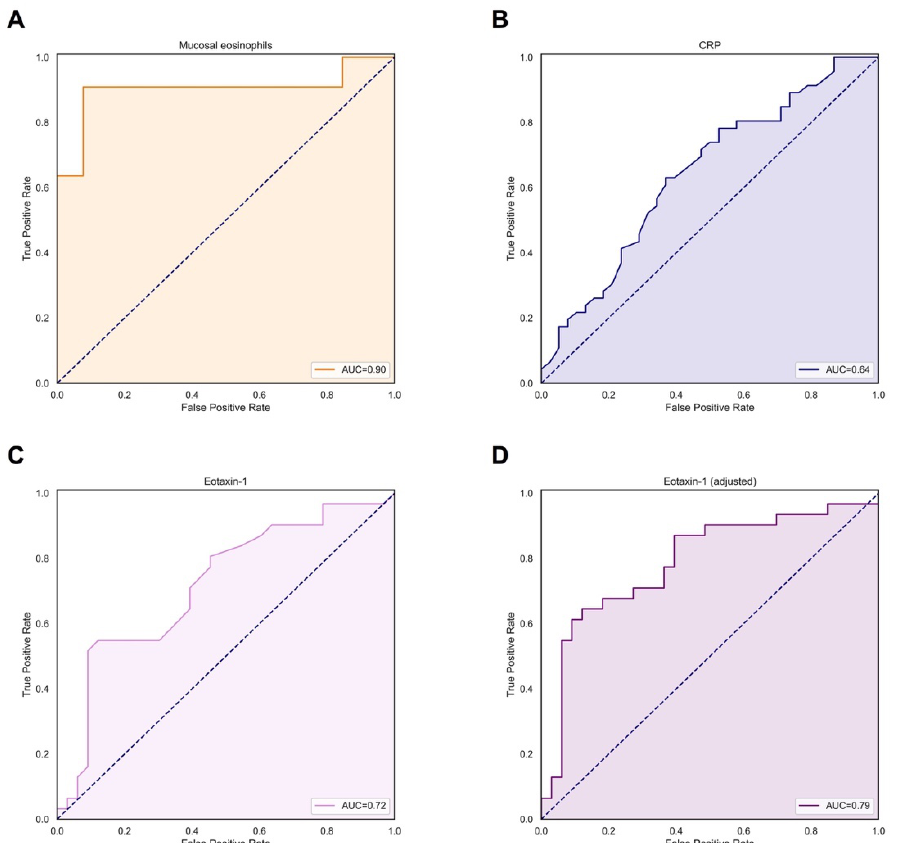
Figure 3. ( A – D ) Receiver operating characteristics (ROC) curves for mucosal eosinophil counts/hpf. ( A ), serum CRP levels (mg/L) ( B ), serum eotaxin-1 levels (ng/mL) ( C ) and adjusted serum eotaxin-1 levels (combined predicted probability of multivariable logistic regression model) ( D ) for discriminating responders and non-responders to vedolizumab among patients with IBD. The best discriminative performance to predict clinical response or remission to vedolizumab induction therapy was demonstrated by mucosal eosinophil counts (although based on a subset of n = 24 patients), while the performance of the multivariable model of serum eotaxin-1 levels ( n = 64) also showed reasonable discrimination. Data presented are based on patients from the discovery cohort. Abbreviations: CRP, C-reactive protein; AUC, area under the ROC curve.